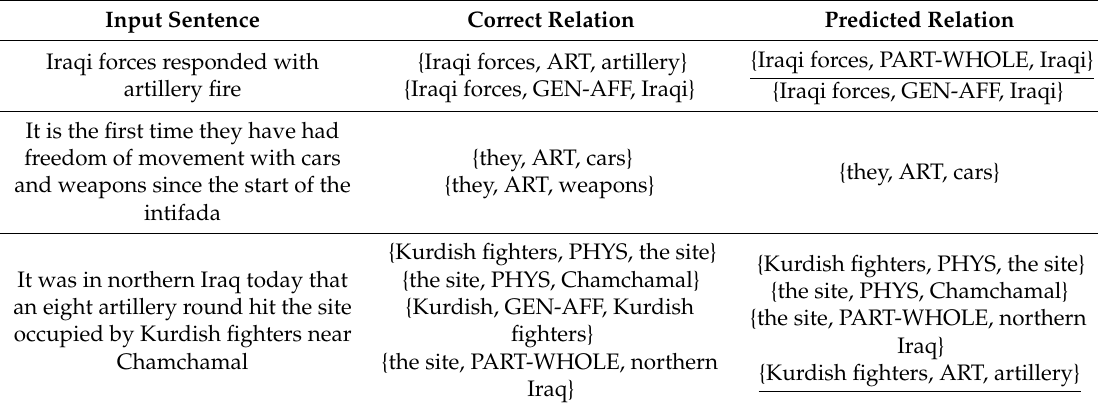
Table 8. Main reasons for errors in the ACE-2005 corpus (underline denotes incorrect results). ART: artifact; GEN-AFF: general entity-a ffi liation; PHYS: physical; PART-WHOLE: part of